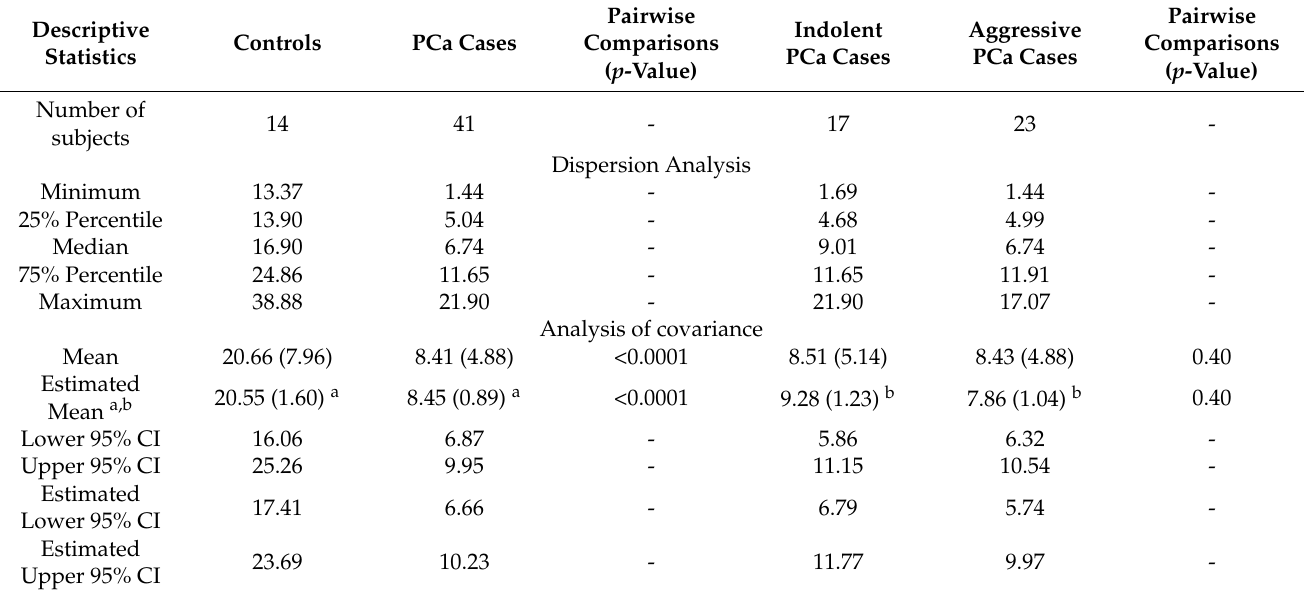
Table 3. DNA repair capacity covariance analyses using age, BMI, and PSA